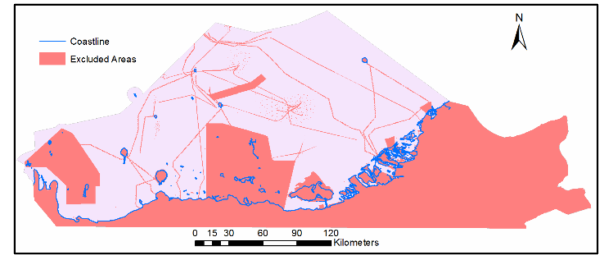
Figure 6: Exclusion mask